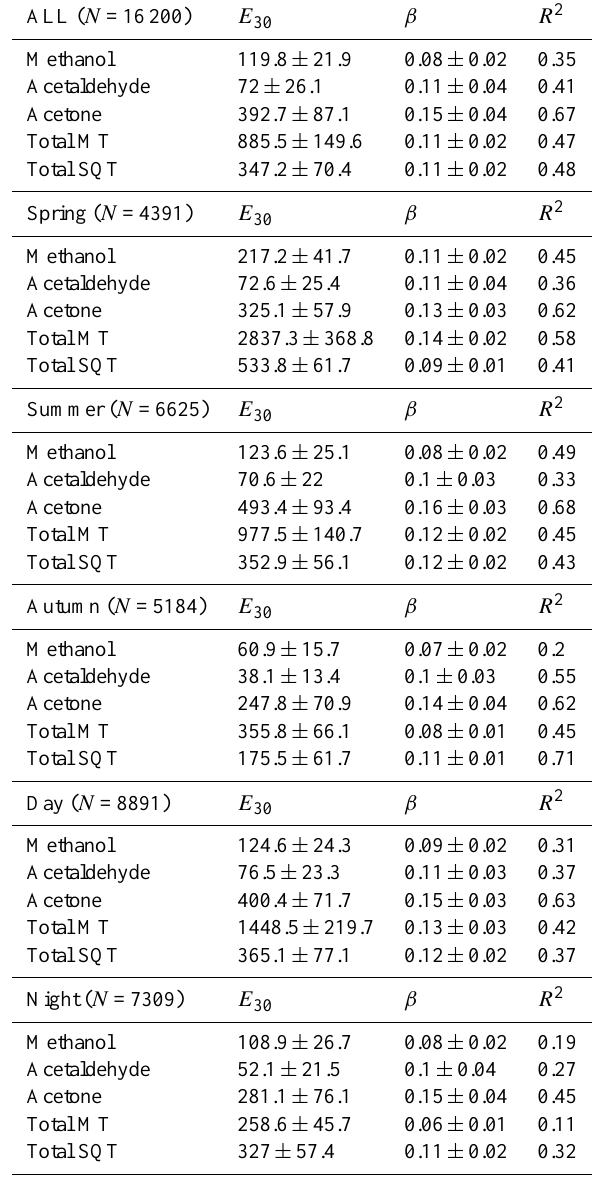
Table 2. Standardized emission potentials ( E 30 , in ngg( d w ) − 1 h − 1 ) and temperature dependencies ( β , in K − 1 ) as derived from nonlin- ear regression analysis (Eq. 5) for the different seasons and light conditions. N is the amount of data used in the calculations and R 2 is the statistical result that expresses the quality of the